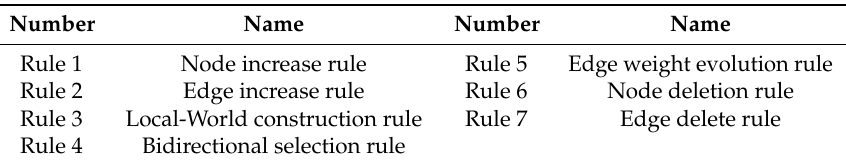
Table 3. SIN Topology Evolution